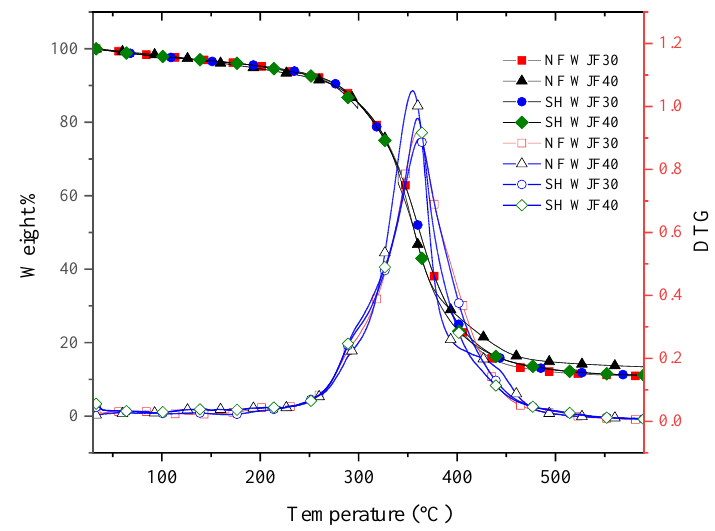
Figure 10. Results of the TGA analysis of the obtained bio-composite.